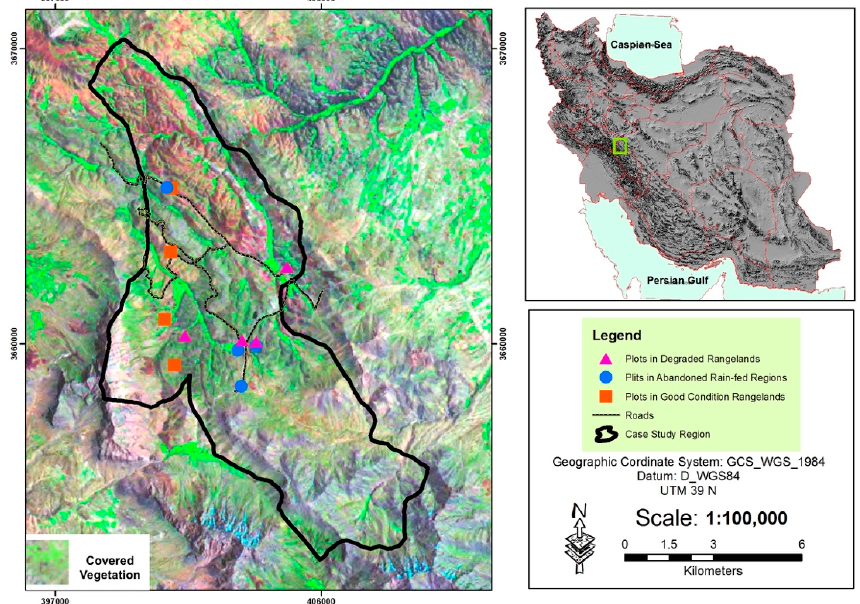
Figure 1. Location of the case study (the background colorful theme is the region’s ETM+ (The Enhanced Thematic Mapper Plus) satellite image). Enhanced Thematic Mapper Plus) satellite